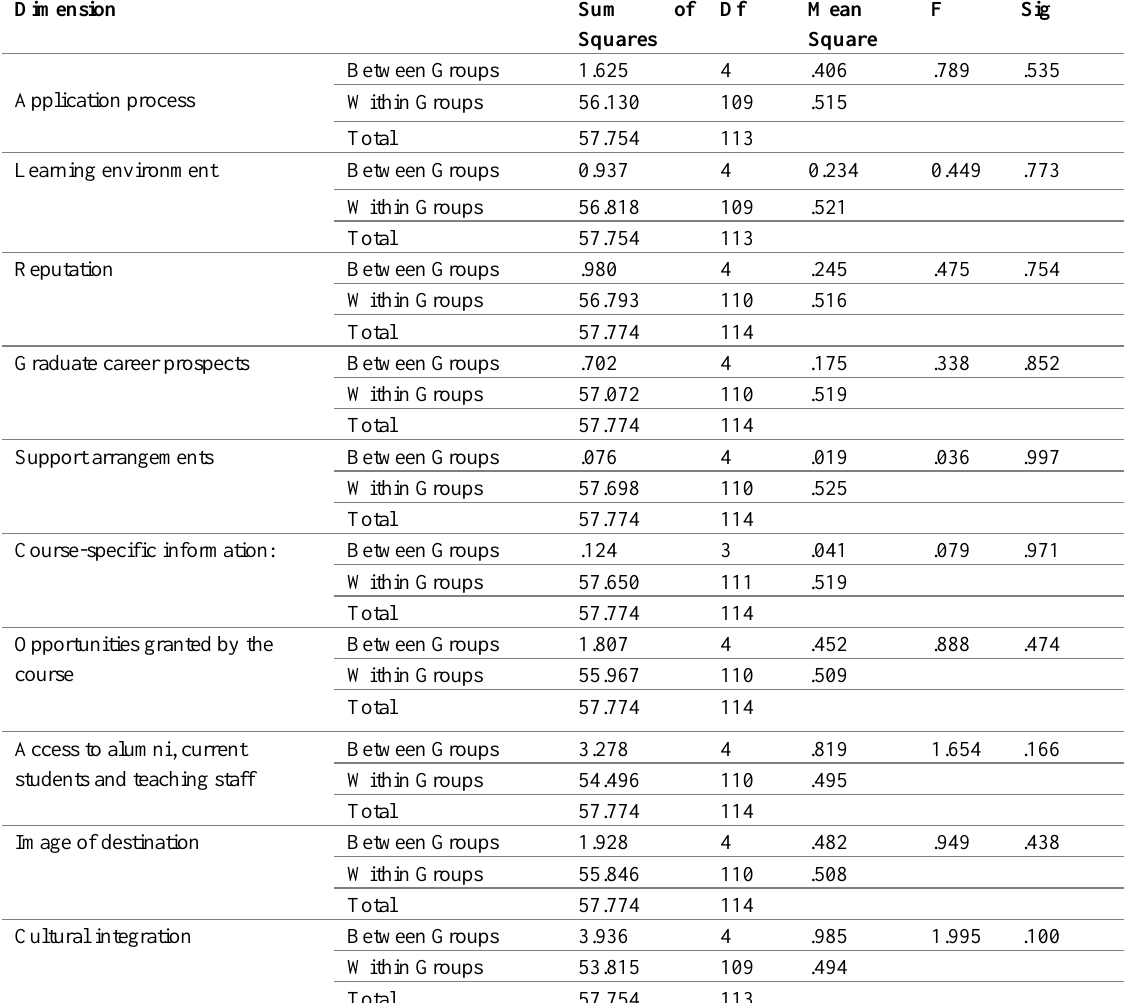
Table 4: ANOVA comparison between-subject effects of proposed qualification and information needs Dimension